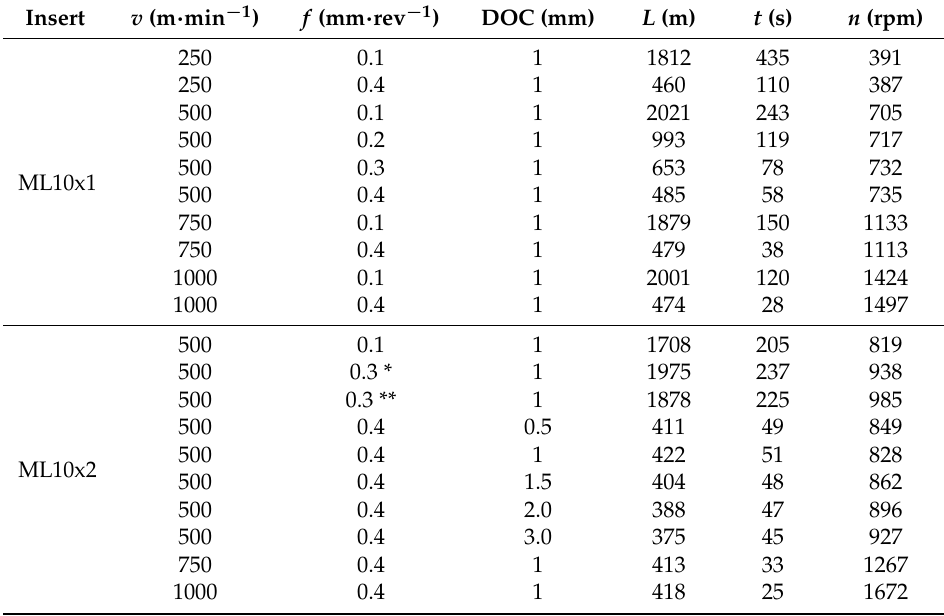
Table 3. Overall set parameters used in the metallic matrix composite (MMC)